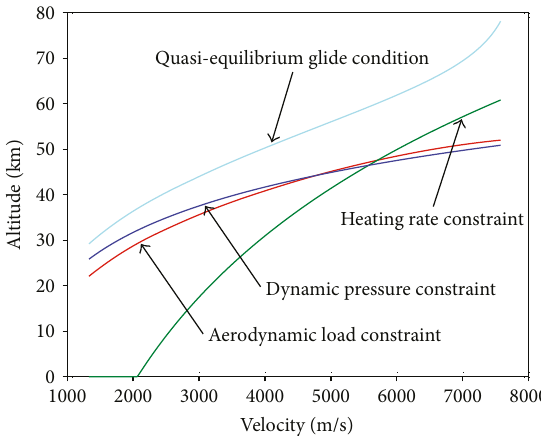
Figure 2: The sketch map of altitude-velocity reentry